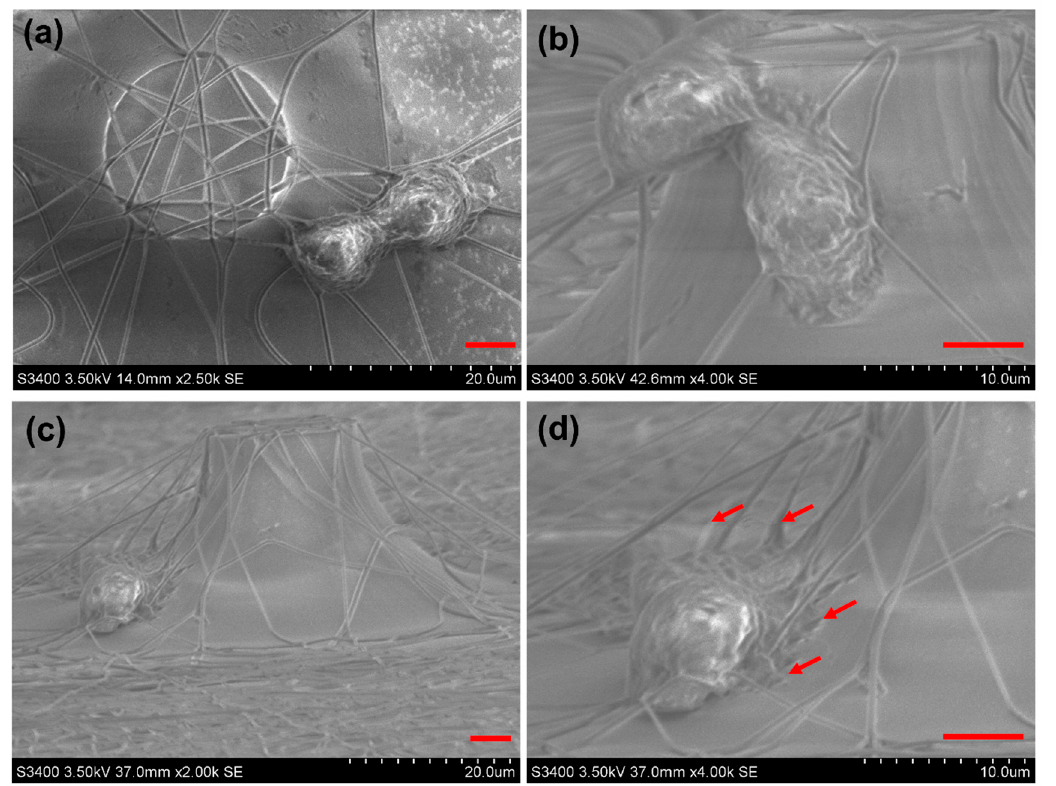
Figure 5. SEM characterization of captured cancer cells on the micropillars coupled with the PLGA nanofibers substrate. The top view ( a ) and the lateral view ( c ) of captured cells. ( b , d ) are the enlarged view of captured cells. The red arrows in ( d ) indicate the microvilli and filopodia of cells. The scale bars are all 5 μ m.